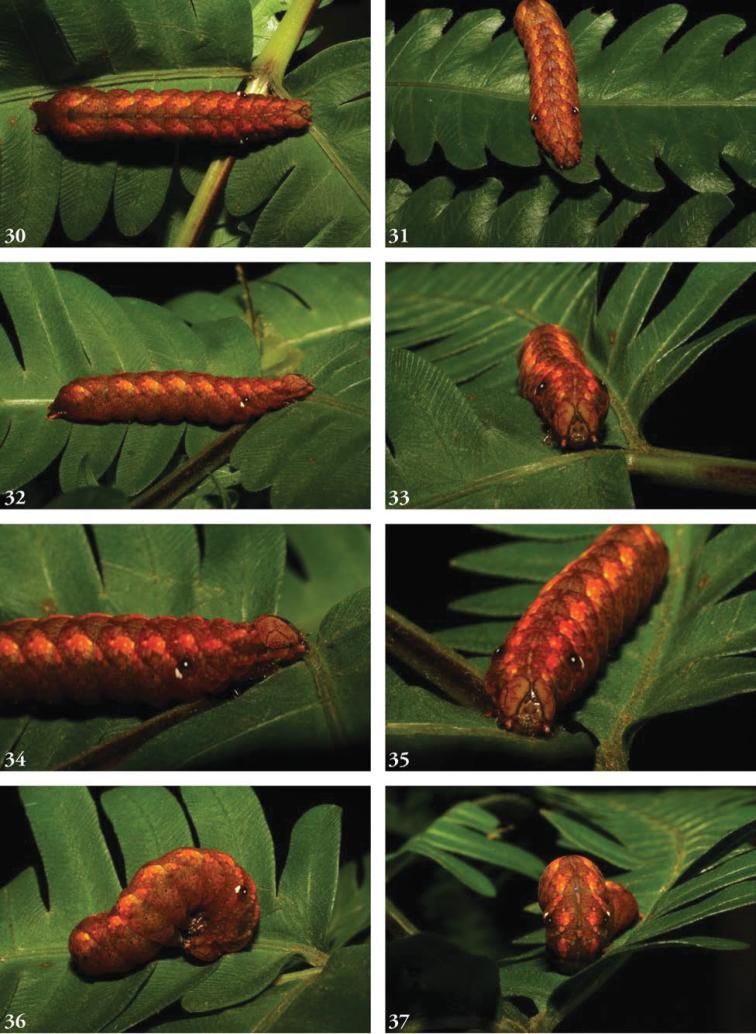
Larvae, brown, last instar. 31USNMENT01463599, 05-SRNP-48763 ♂ DHJ408116 32 SNMENT01463665 05-SRNP-2726 ♂ DHJ402483 33USNMENT01463599, 05-SRNP-48763 ♂ DHJ408117 34USNMENT01463599, 05-SRNP-48763 ♂ DHJ408121 35USNMENT01463599, 05-SRNP-48763 ♂ DHJ408123 36USNMENT01463599, 05-SRNP-48763 ♂ DHJ408124 37USNMENT01463599, 05-SRNP-48763 ♂ DHJ408125 38USNMENT01463599, 05-SRNP-48763 ♂ DHJ408126.